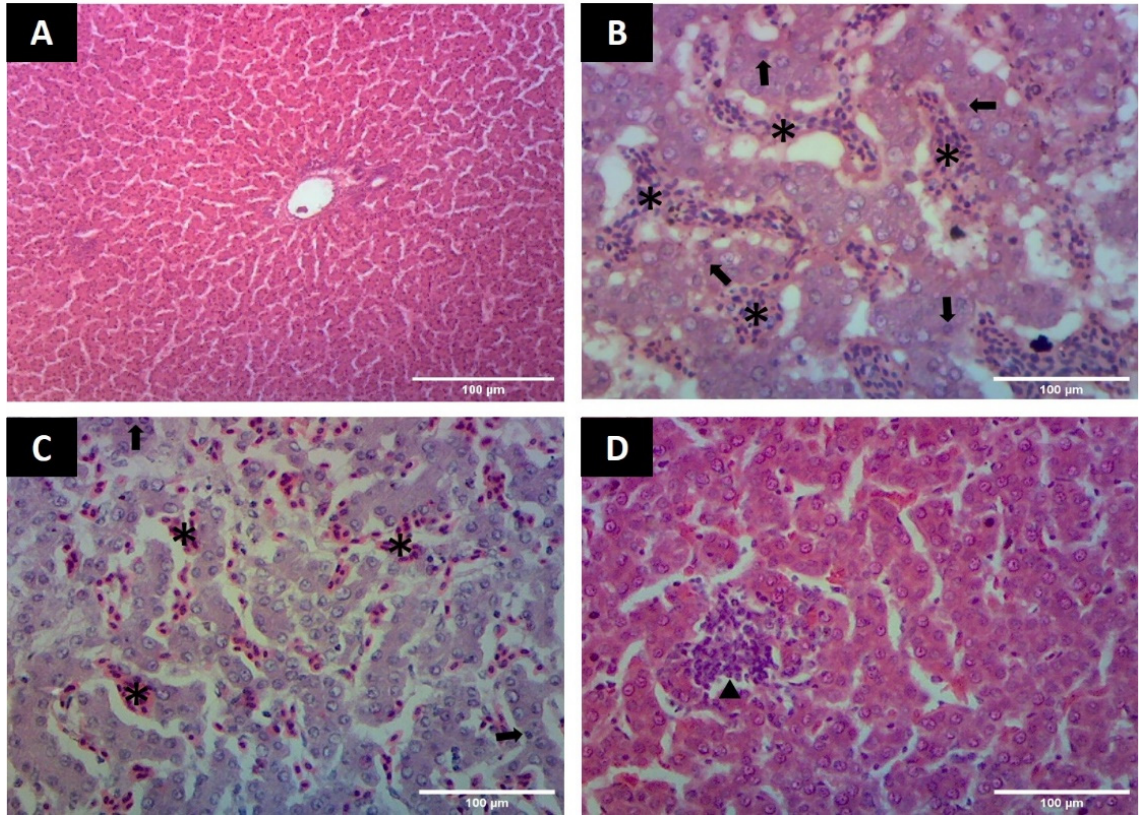
Figure 3. Photomicrographs of liver showing microscopic changes ( A ) Liver from group A showing